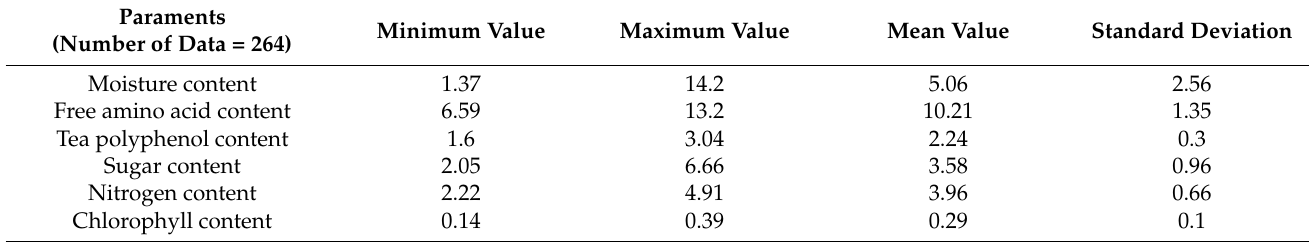
Table 3. Some basic statistical data on the measured tea leaf